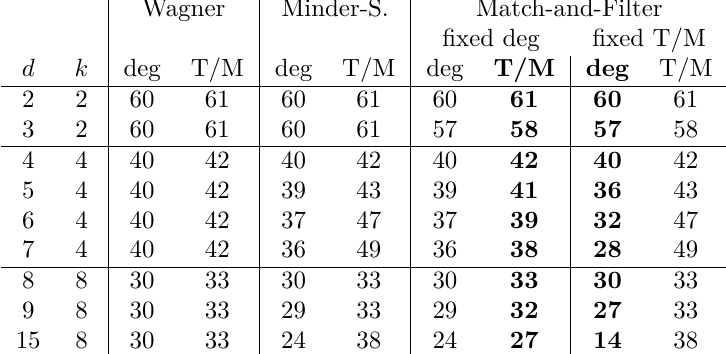
Figure 15: Comparison of the bit complexities of the algorithms k -list [Wag02], extended k -list [MS09] and our Match-and-Find for finding a multiple of a polynomial of degree n =